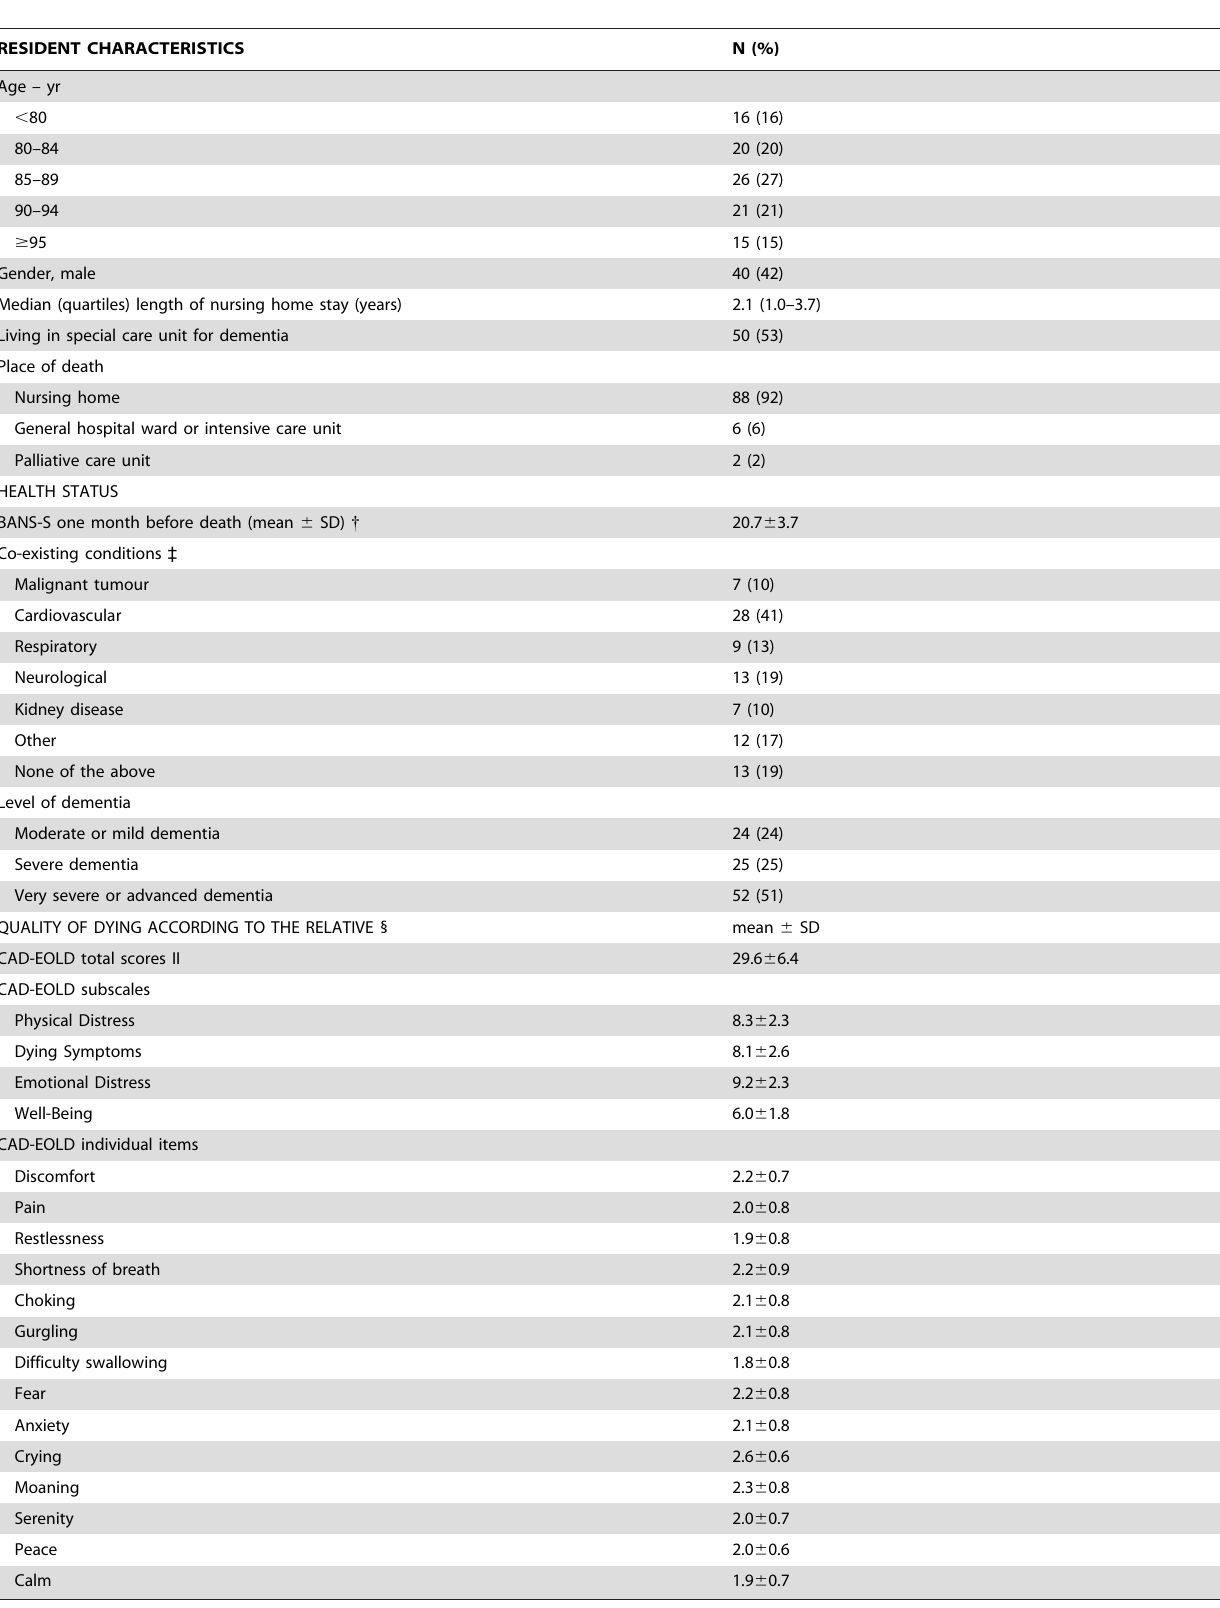
Table 1. Deceased Nursing Home Residents with Dementia in Flanders, Belgium: Description of the Sample (N =101).*.